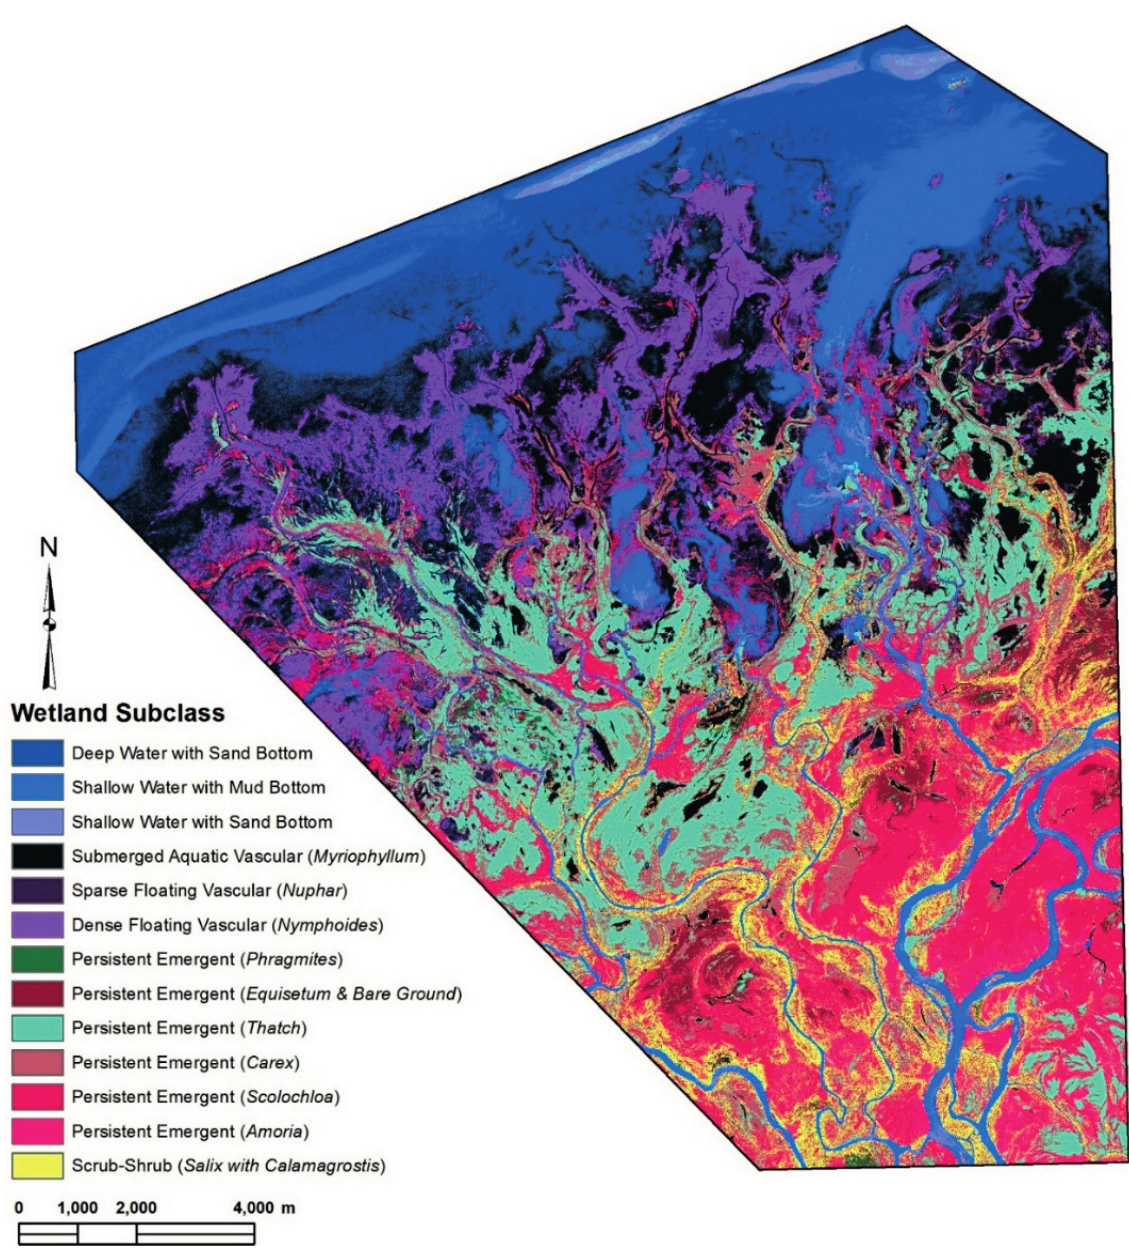
Figure 7. Level 4 classification at the Subclass level of the Cowardin